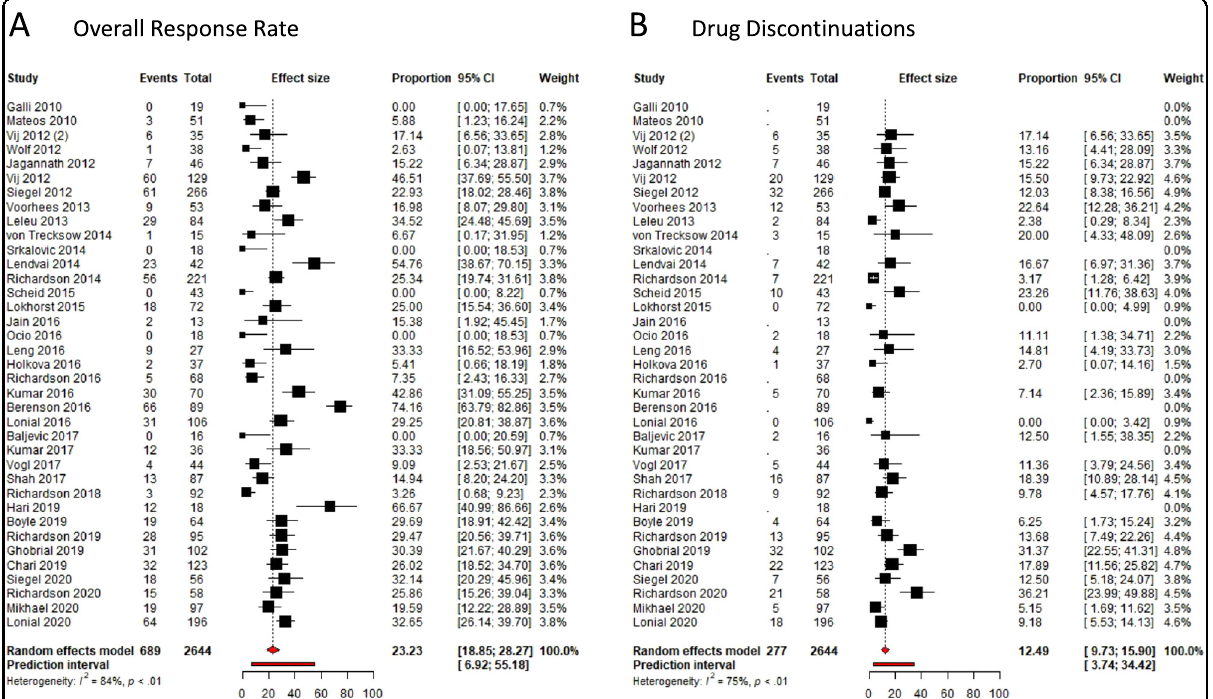
Fig. 3 Meta-analysis of overall response rates and dose-limiting toxicities in phase II trials. A Overall response rates per included phase II trial. B Drug discontinuations - per included phase II trial. Forest plots are arranged by the population size of trials within each year of publication. Squares represent estimated proportions, with the size of the squares representing the weight of each trial according to the inverse variance method. Horizontal lines through the squares indicate 95% CIs. The points of the diamond indicate the 95% CI of the pooled mean. The horizontal line at the bottom indicates the prediction interval. Blank lines indicate missing information from the trial